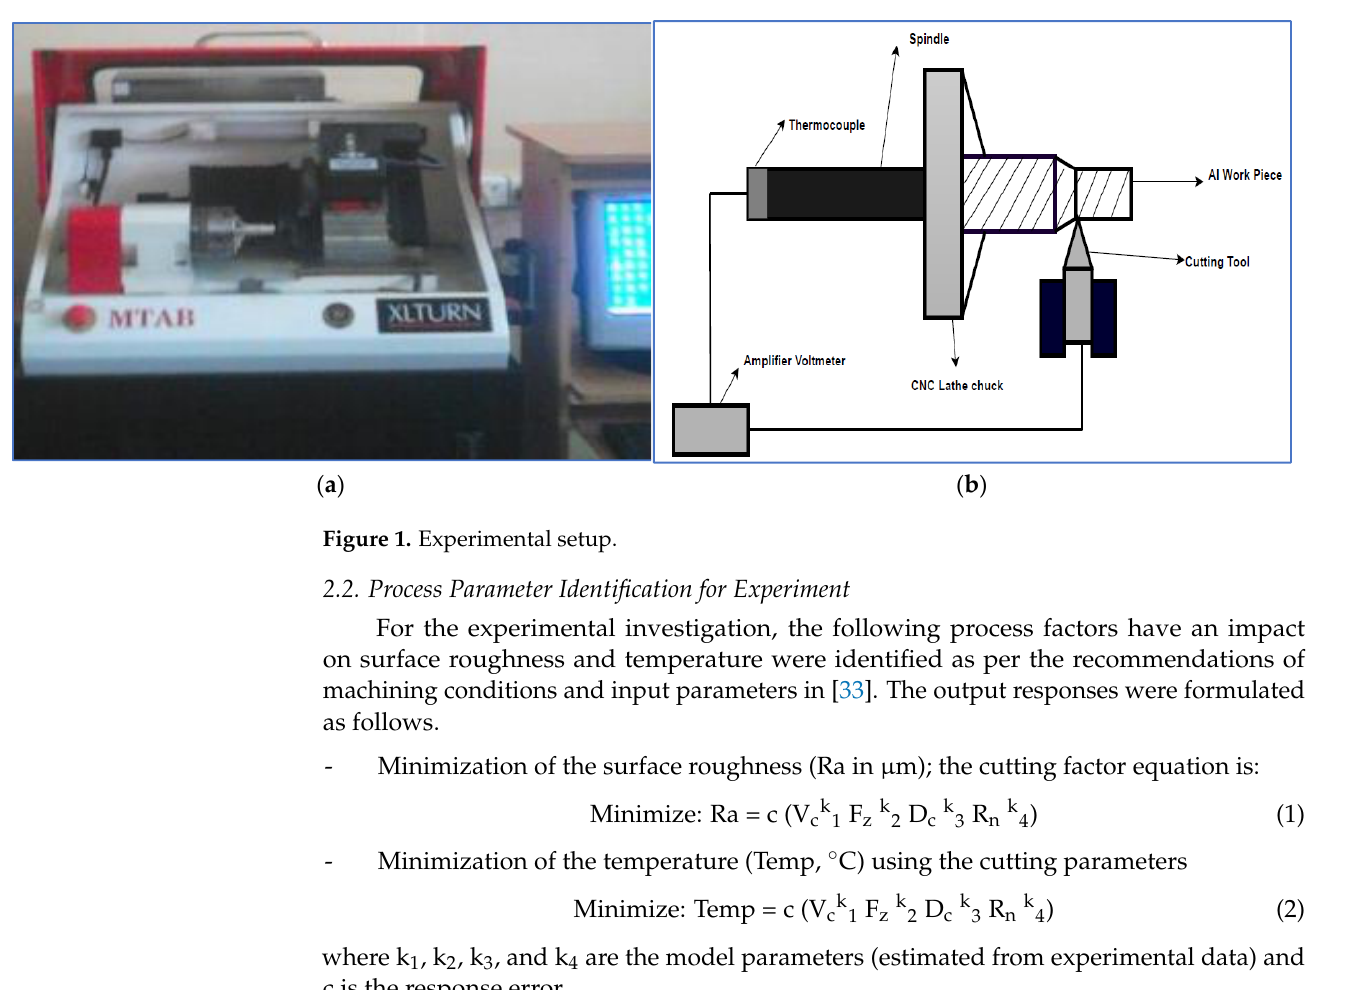
Table 2. The factorial levels of output process parameters.